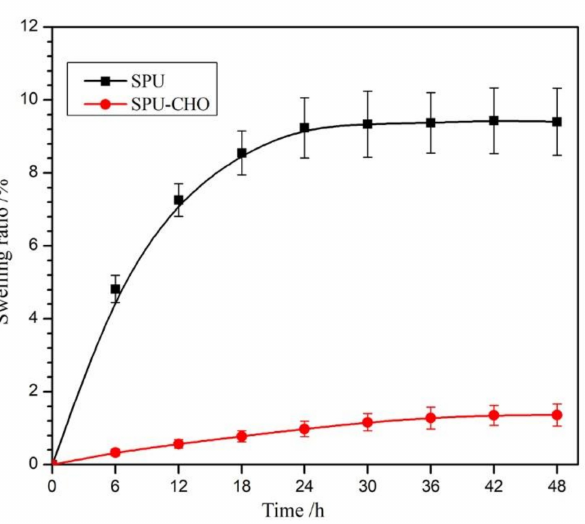
Figure 5. The time dependence of water uptake of SPU and SPU-CHO film at 37 ◦ C in deionized water ( n =